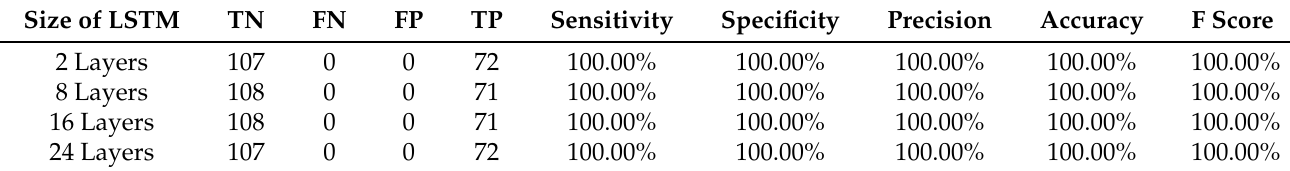
Table 2. Experiment phase 1: model training comparison with 100 epochs.